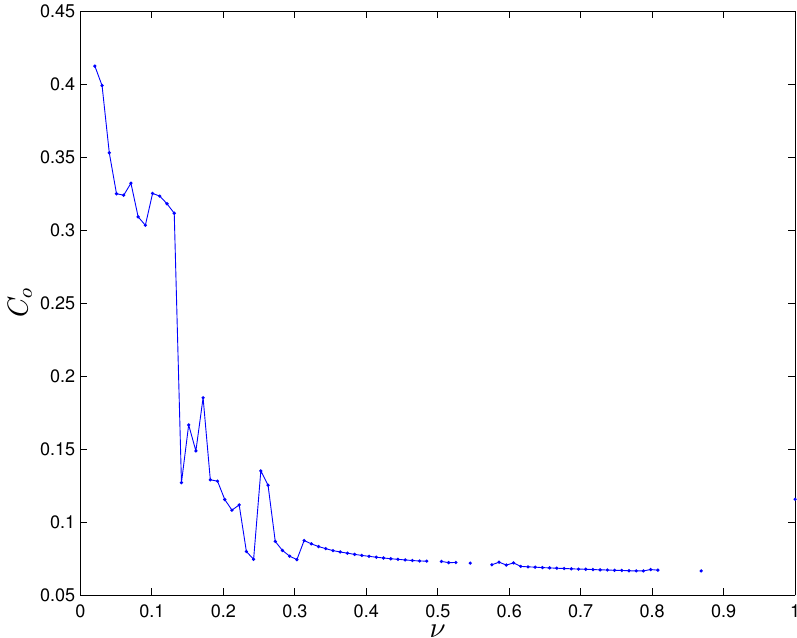
Figure 6. C o complexity of the fractional order map (6) with ν varying and b =